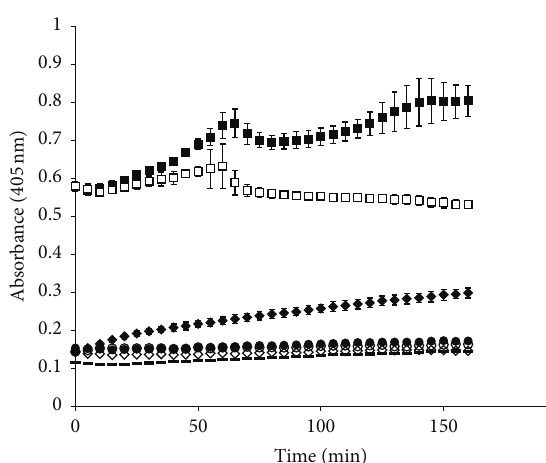
Figure 2: Detection of caspase 3 activity in A. millepora host tissue. Evolution of the absorbance recorded over time in coral host tissue ( ◼ ) and its negative control ( ◻ ); with commercial caspase 3 ( Q ) and its negative control ( ◊ ); in the zooxanthellae fraction ( e ) and its negative control ( I ); and in the blank